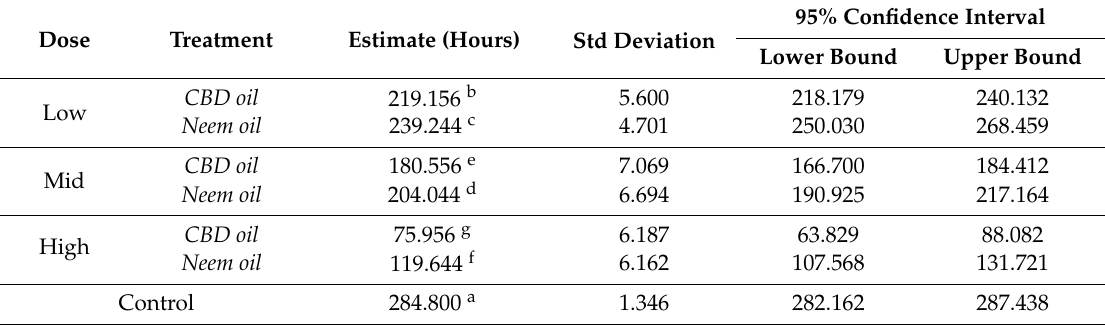
Table 3. Overall survival time of larvae in relation to dose and treatment (Chi-square: 18.646, df = 3, p < 0.001). Means of the same column followed by the same letter are not significantly di ff erent (Long Rank test, p =